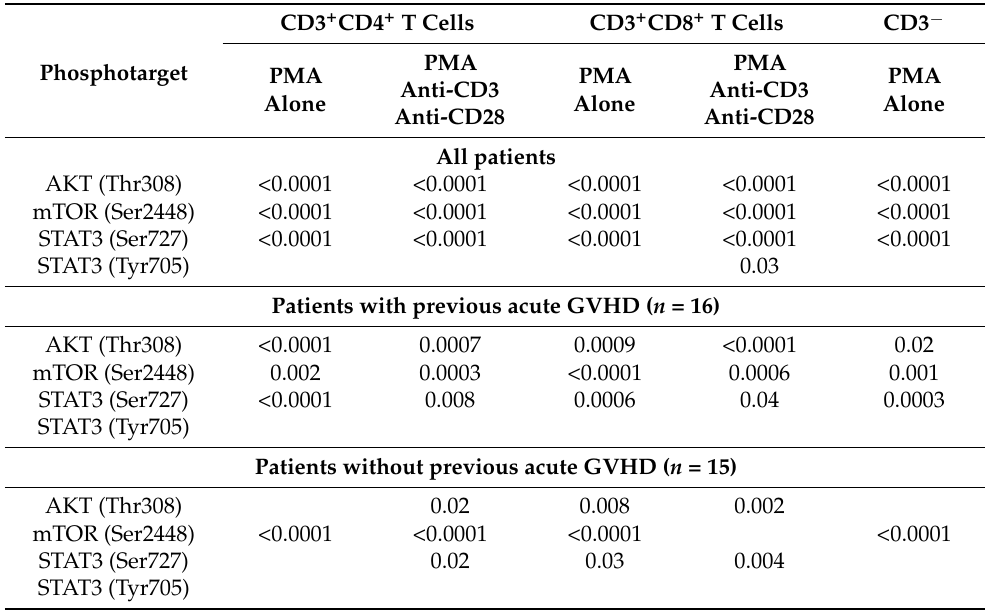
Table 2. The effects of PMA stimulation on circulating CD3 + CD4 + T cells, CD3 + CD8 + T cells and CD3 − mononuclear cells derived from allotransplant recipients on day +90 post-transplant. Cells were stimulated either with PMA alone or with PMA combined with anti-CD3 + anti-CD28, and the effect of these stimulations on the phosphorylation of AKT/mTOR/STAT3 was evaluated by flow cytometry. All p -values refer to a statistical comparison (i.e., increased phosphorylation) between cultures with an activation signal (PMA alone or PMA+anti-CD3 + anti-CD28) and the corresponding control cultures prepared in medium alone. All comparisons were carried out using the Wilcoxon signed-rank test and we only present stimulations with a p -value <